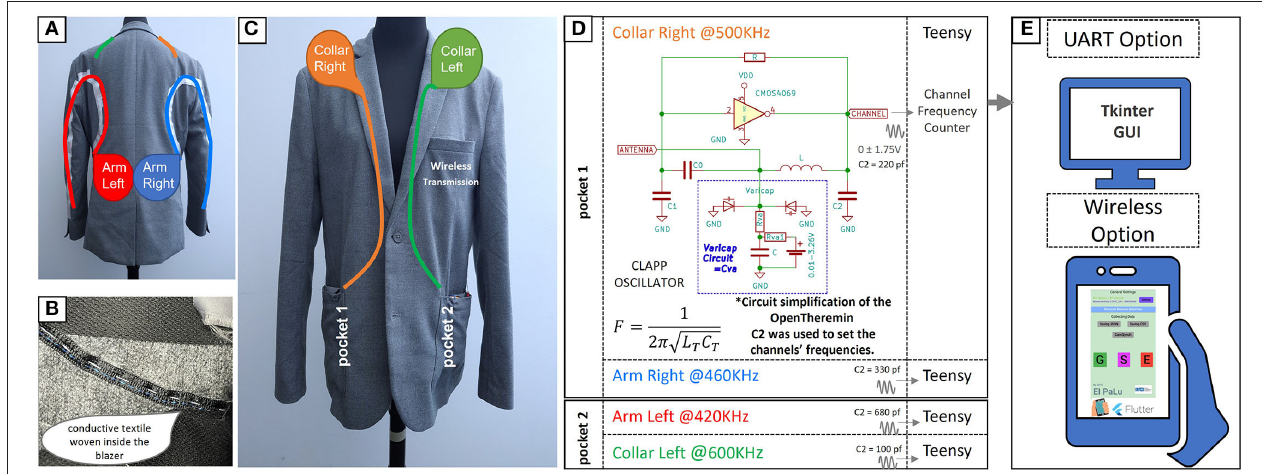
FIGURE 1 | Electronic garment design “the MoCaBlazer,” (A) is the back part of the blazer, (B) is the textile cables sewn inside the garment, (C) is the front part of the blazer, (D) is the circuit simplification design of the Clapp oscillator with the antennas, (E) are the two options for collecting data coming from the blazer; with and UART-wired option, and a Bluetooth based android application (Flutter framework) as the wireless